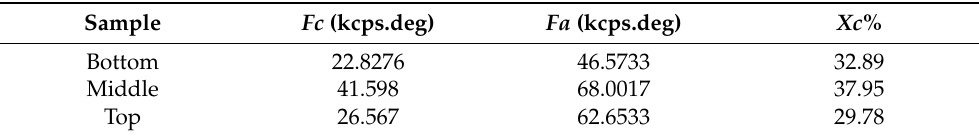
Table 5. Degree of crystallinity of Gigantochloa pruriens bamboo based on the axial position. Sample Fc (kcps.deg) Fa (kcps.deg) Xc %